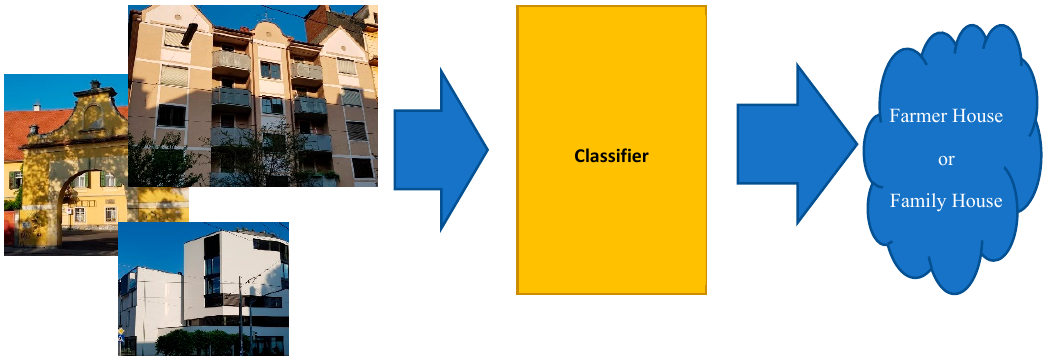
Figure 1. The “House type” classification’s overall process pipe (Source: own images).